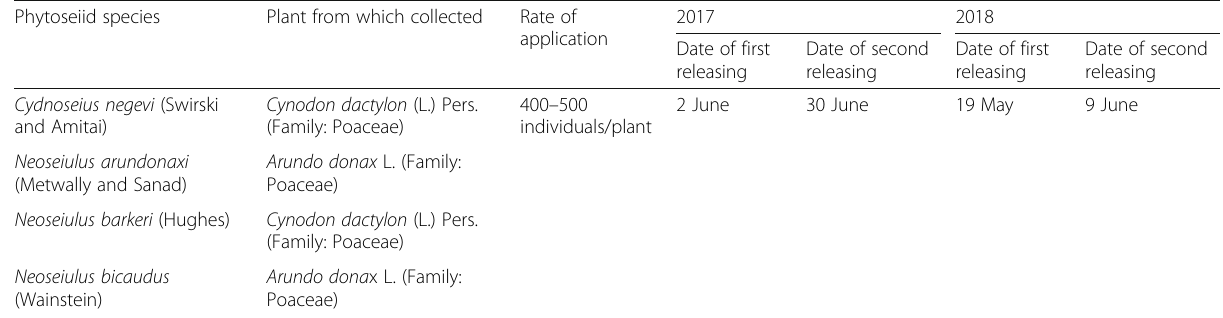
Table 1 Releasing rates and dates of tested phytoseiid species against Frankliniella occidentalis on pepper plants during the two seasons of 2017 and 2018 Phytoseiid species Plant from which collected